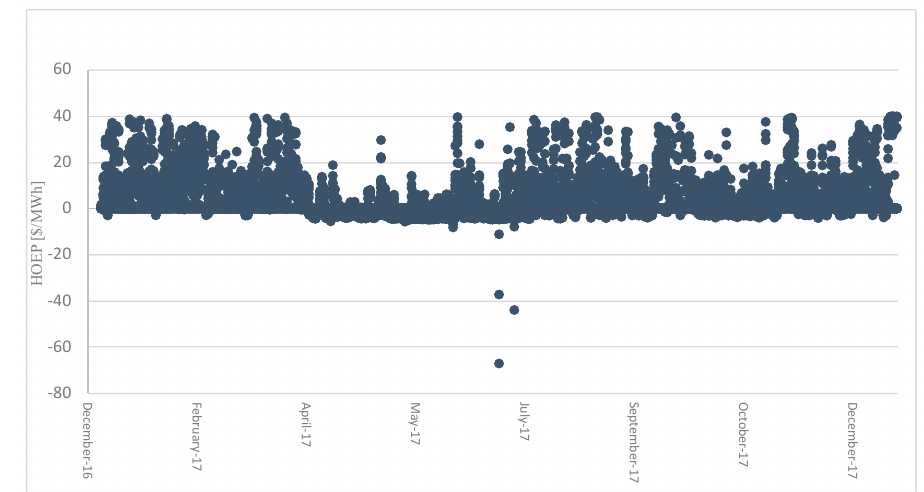
Figure 4. The hourly Ontario energy price (HOEP) in $/MWh [31].